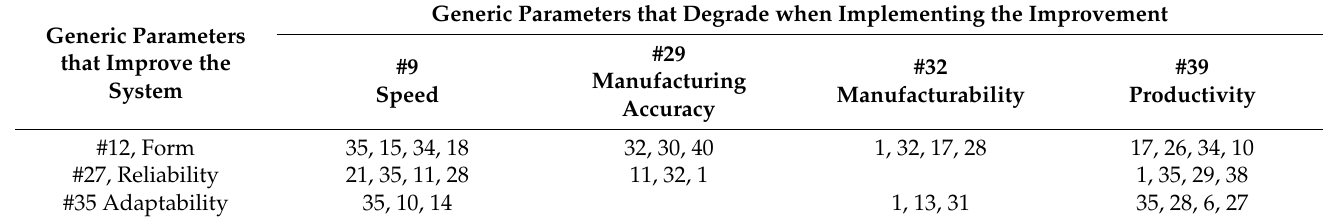
Table 1. Matrix to resolve the technical contradiction presented by the proposed ideal plantar orthosis system. Generic Parameters